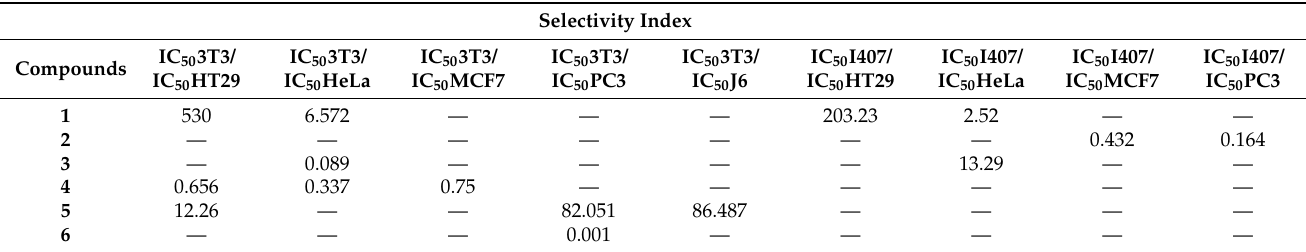
Table 3. Selectivity indices of compounds against cancer cell lines (IC 50 ) using 3T3 or I407 normal cells (IC 50 ) as